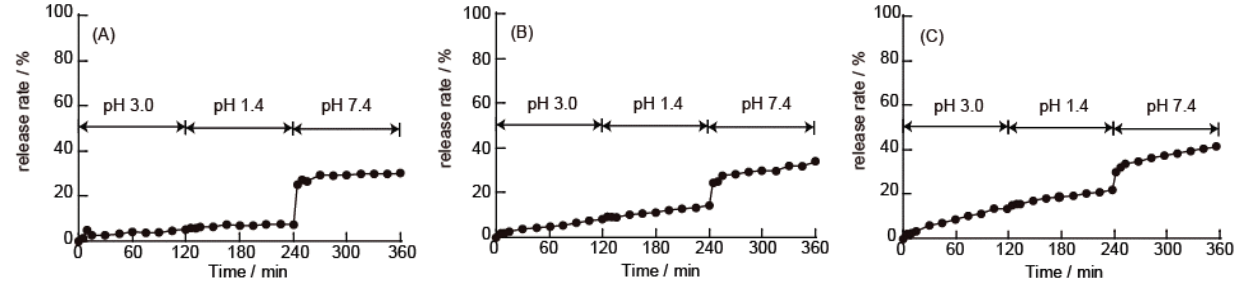
Figure 6. The effect of molecular weight of PAH on the release of TRITC-Insulin from (PAH/PSS) 5 microcapsules. The average molecular weight of PAH used was 1000 ( A ), 15,000 ( B ), and 70,000 ( C